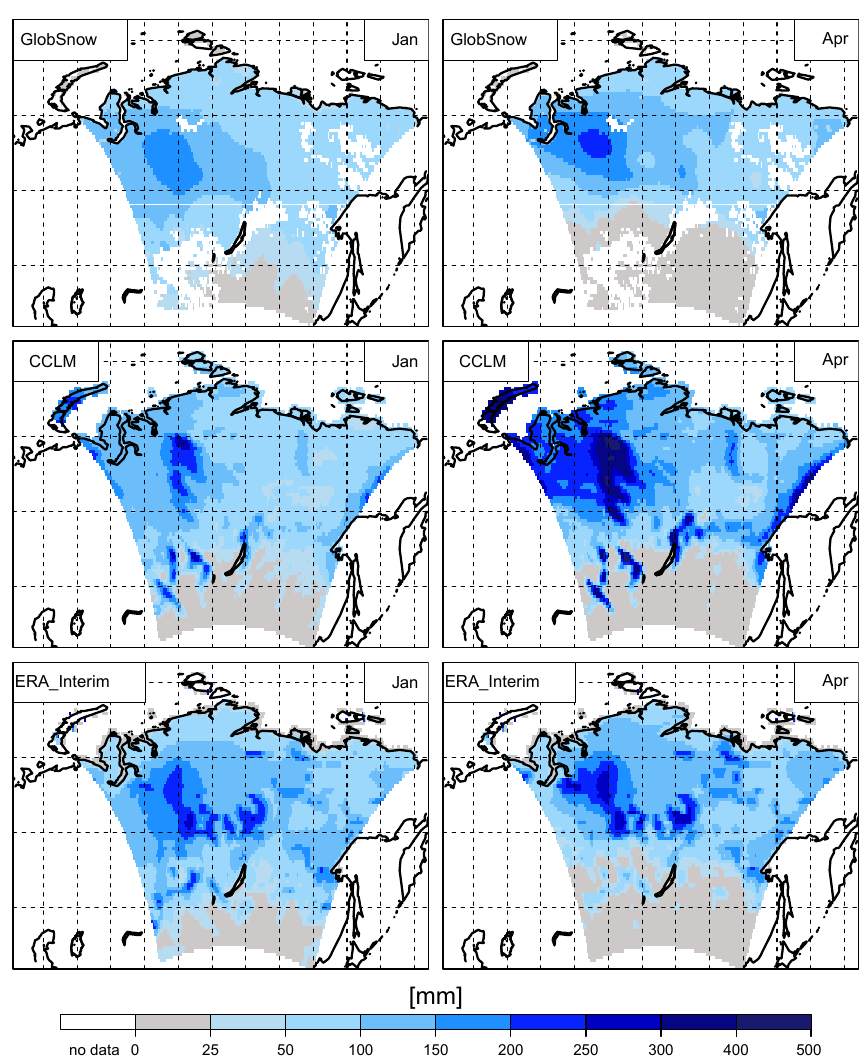
Fig. 3. Long-term mean of SWE [mm] (1987–2010) of GlobSnow, CCLM and ERA-Interim for January and April. White boxes within the model domain indicate missing values of